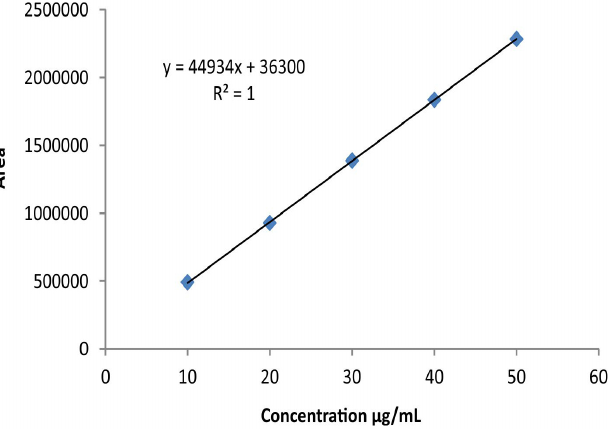
FIGURE 5 - Calibration curve of Diclofenac potassium. TABLE III - Combinations tested to evaluate the robustness of the analytical method, evaluating the conditions 1 Combination